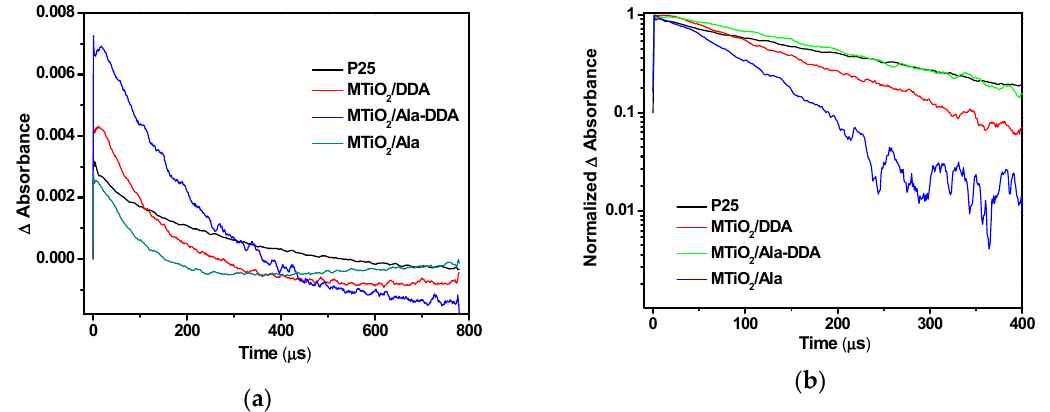
Figure 9. ( a ) Temporal profiles in atmosphere of transient IR absorption and ( b ) normalized decay curves at 1910 cm − 1 of the four catalysts.